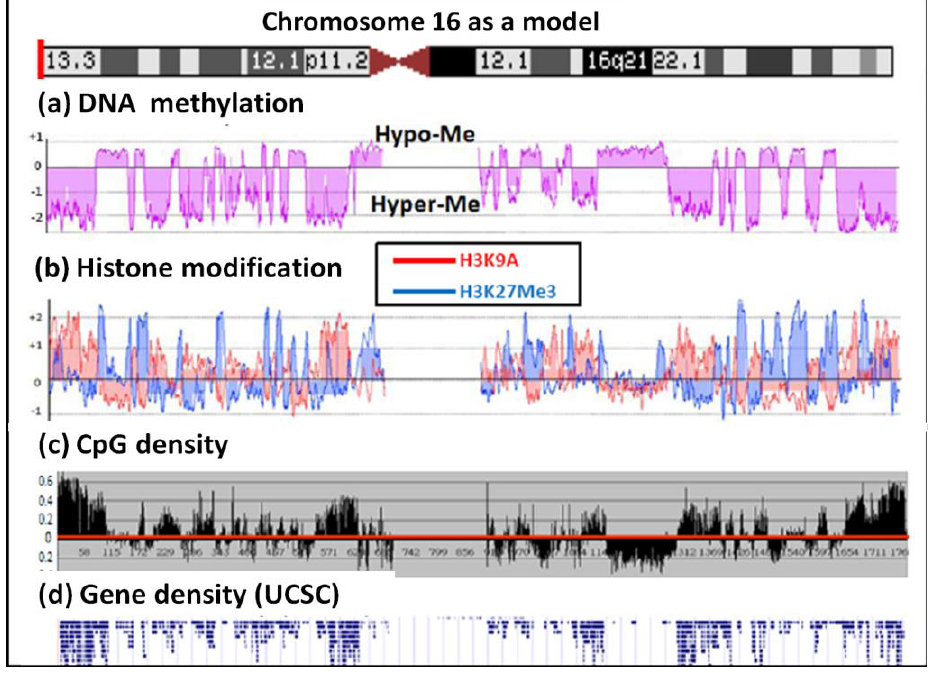
Figure 4. Domain organization in chromosome 16: (a) CG methylation ; (b) histone H3K9Ac/H3K27Me3 modification; (c) CpG density and (d) gene density. The CpG density is calculated as the logarithm of the number of CpG sequences within a 50 kb window and the log value is increased by two to exhibit the differential density